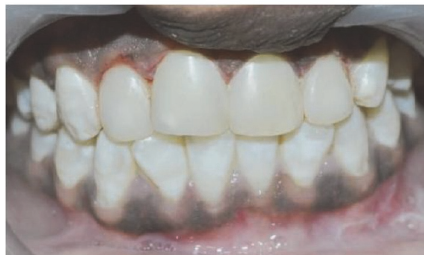
Figure 5: Finished and polished restoration.